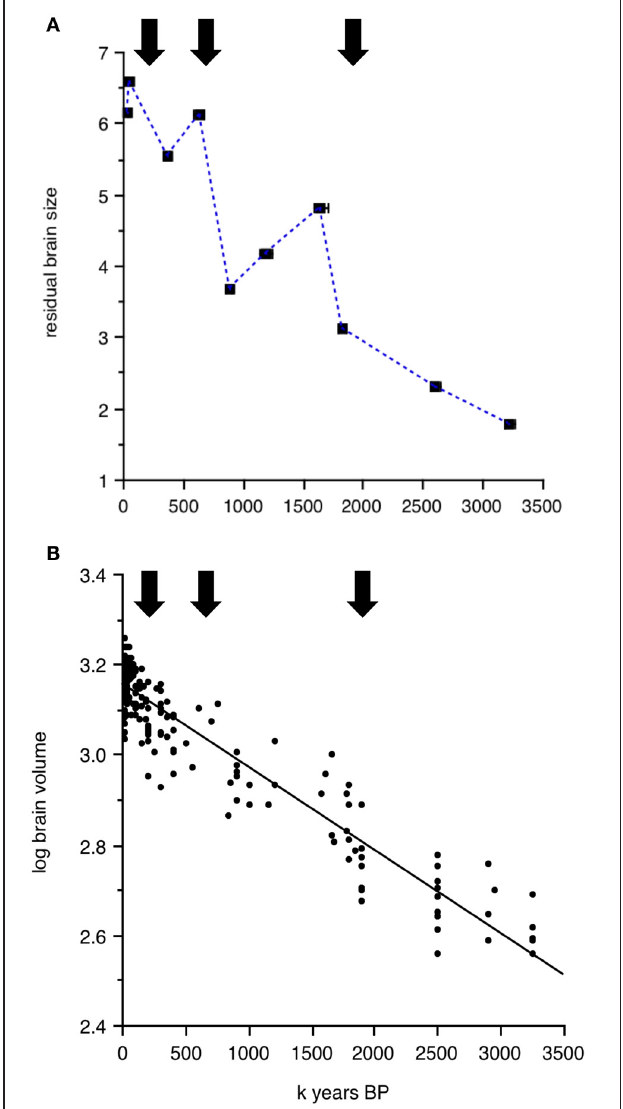
FIGURE 5 | Dates of major hominin emigration events out of Africa (arrows) according to Templeton’s (2002, 2005) plotted against (A) studentized residuals of log brain size regressed against log body size averaged for the time periods and clades presented in Table 1. (B) Continuous change of log absolute brain size as a function of time from 3.2 million to 10,000 years